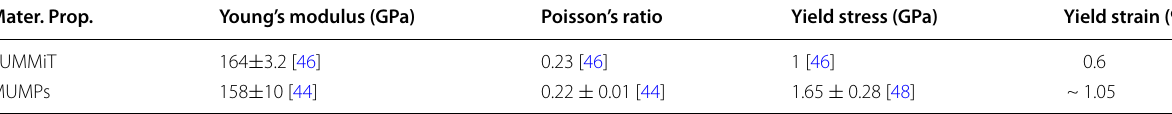
Table 3 Overview of the constituent material properties of the SUMMiT and MUMPs processes Mater.